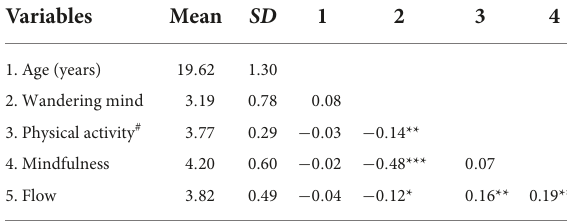
TABLE 1 Descriptive statistics among key study variables ( n =